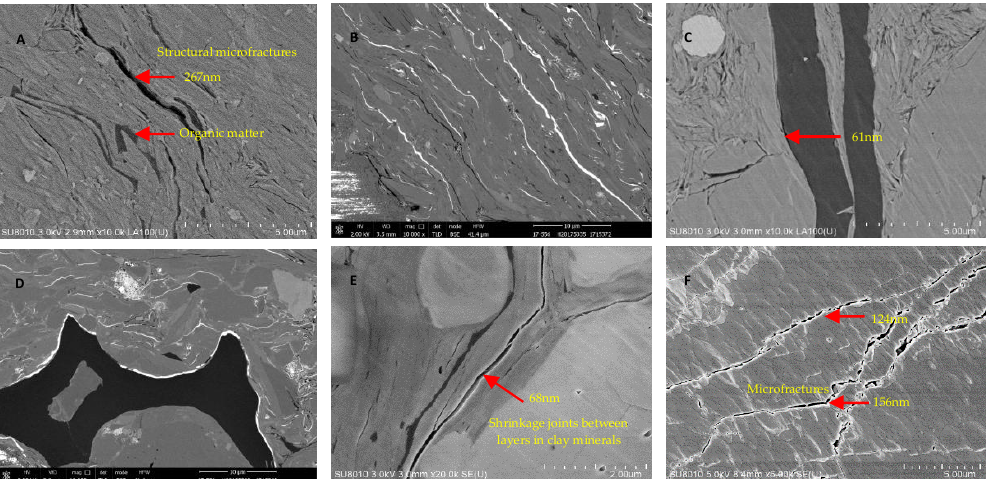
Figure 4. Three-dimensional distribution of bedding-related micro-fractures. ( A ) YL30-19 Structure micro-fractures, cracks are impregnated with organic matter; ( B ) YL4-20 Bedding structure micro-fractures; ( C ) YL171-5 Organic matter edge shrinkage seam; ( D ) YB21-2 Organic matter edge shrinkage seam; ( E ) FY1-13 Diagenetic shrinkage joints in clay minerals; ( F ) YL4-8 Internal micro-fractures of shell